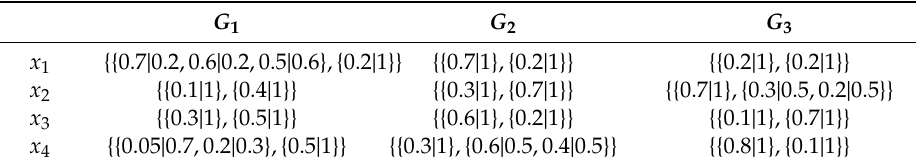
Table 7. The probabilistic dual hesitant fuzzy decision matrix.